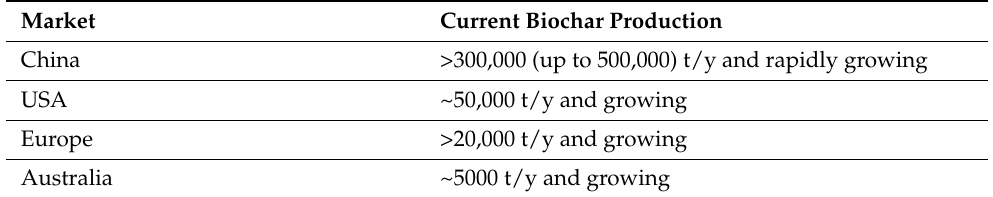
Table 9. Current biochar production in the top global markets.